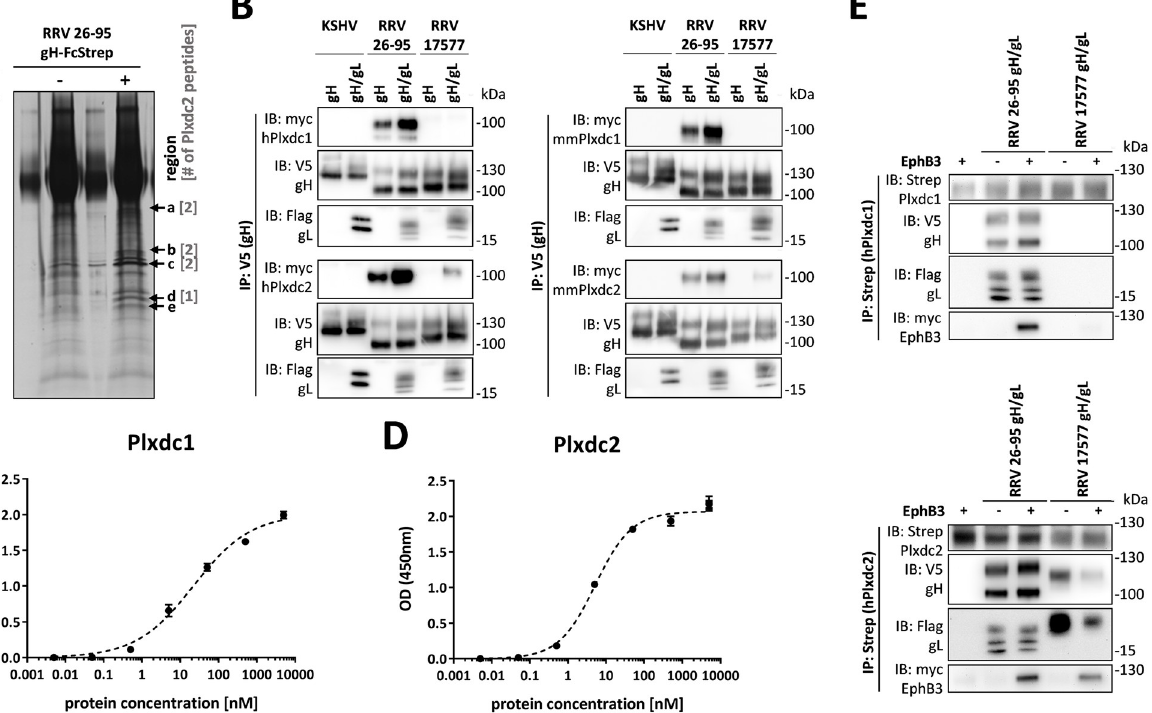
PLOS Pathogens| https://doi.org/10.1371/journal.ppat.1008979 March 3,